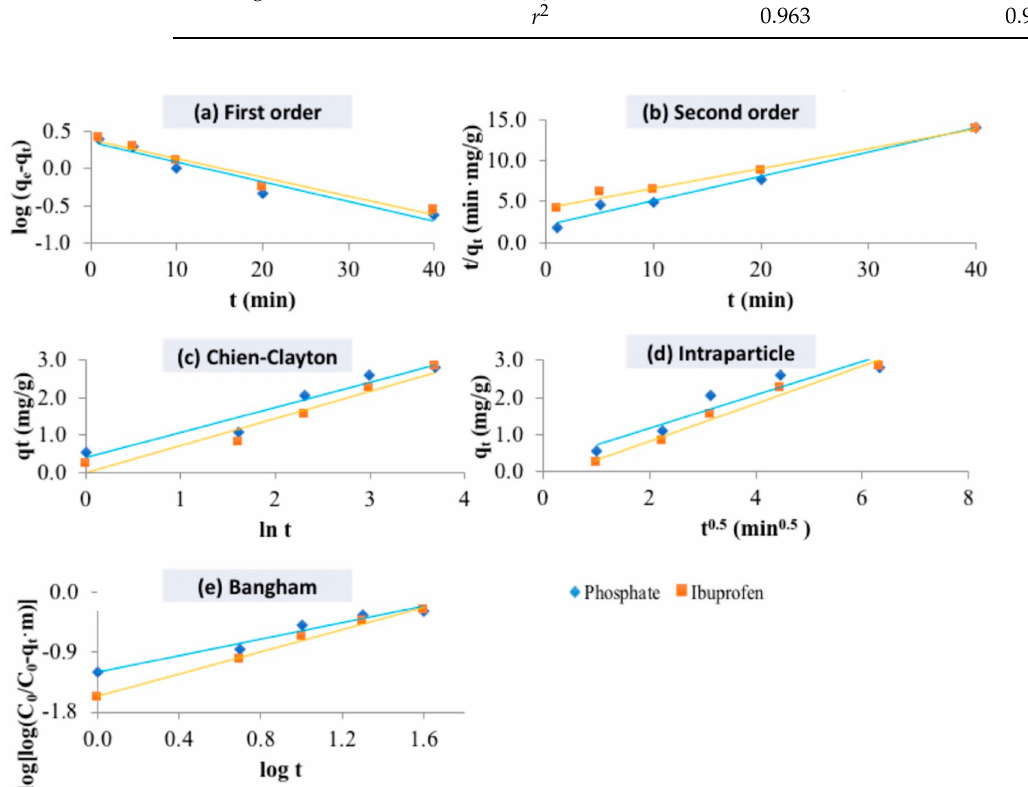
Figure 2. Kinetic plots for the adsorption of phosphate and ibuprofen onto calcined layered double hydroxide (LHD C ) applying different kinetic models: ( a ) pseudo-first-order, ( b ) pseudo-second-order, ( c ) Chien–Clayton model, ( d ) intraparticle diffusion model, and ( e ) Bangham